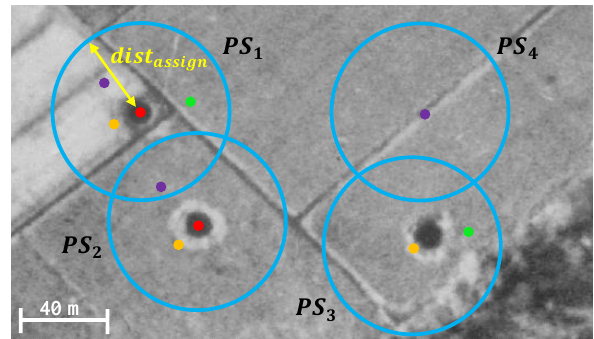
Figure 1: Subset of an aerial wartime image covered by a total of four different images with the centres of the respective detection results of the MPP procedure in red, orange, green and purple; these detections are assigned to point sets 𝑃𝑆 𝑖 according to criteria described in the main